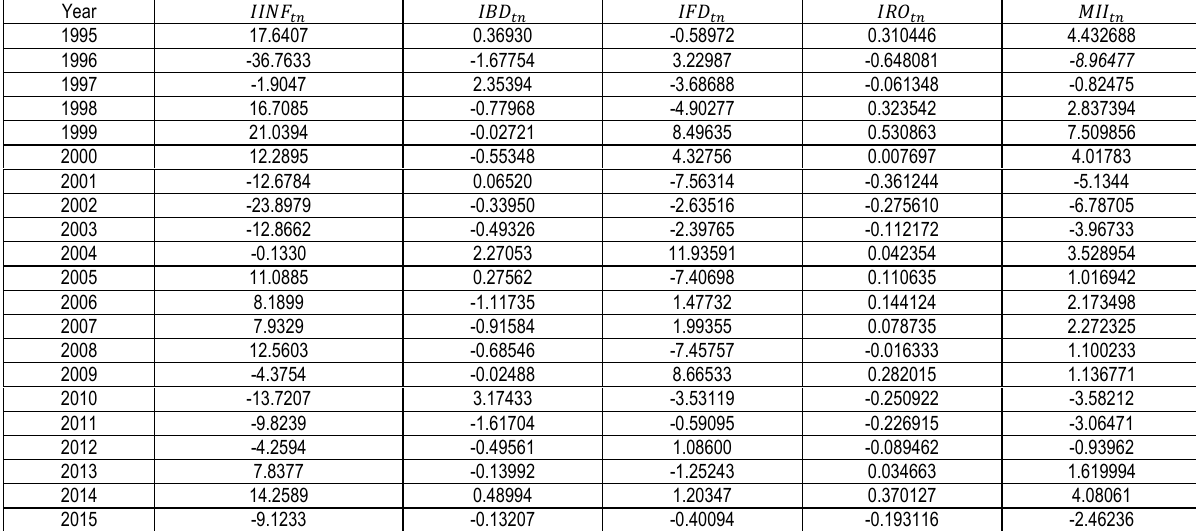
Table 2 .Calculation of macroeconomic instability index on the example of Ukraine in 1995 ‒2 015 (own calculations based on Eurostat data) 𝑀𝐼𝐼 𝑡𝑛